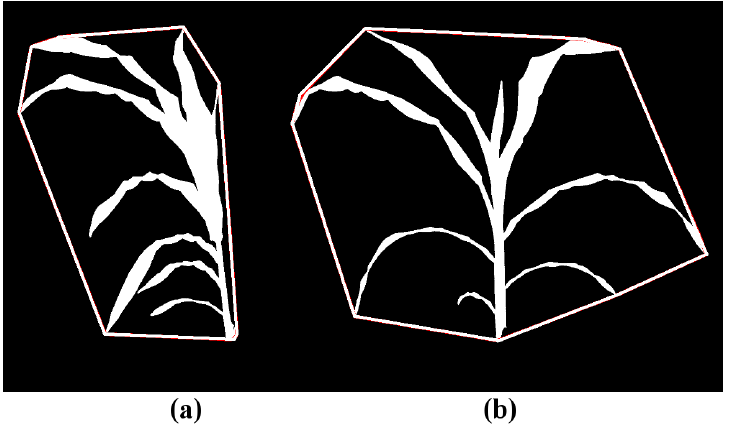
Figure 2. Illustration of view selection: ( a ) binary image of a maize plant enclosed by the convex-hull at a side view of 0 ◦ ; and ( b ) binary image of the same maize plant enclosed by the convex-hull at a side view of 90 ◦